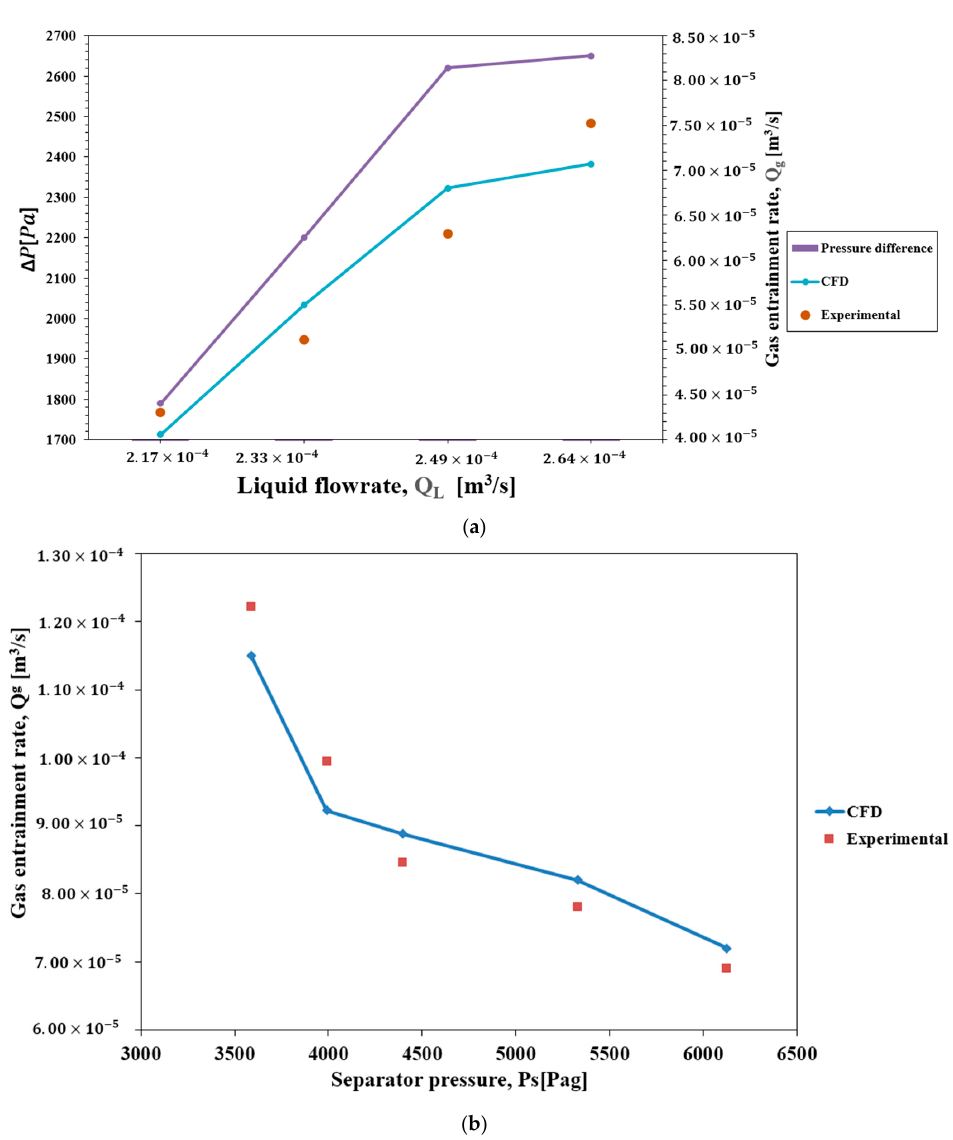
Figure 4. ( a ) Effect of motive liquid flow rate on the air entrainment (nozzle diameter = 6 mm) and pressure difference between the beginning and the end of the nozzle. ( b ) Effect of separator pressure on gas entrainment at constant liquid flow rate of 2.85 × 10 − 4 m 3 /s for the air–water system (nozzle diameter = 6 mm)